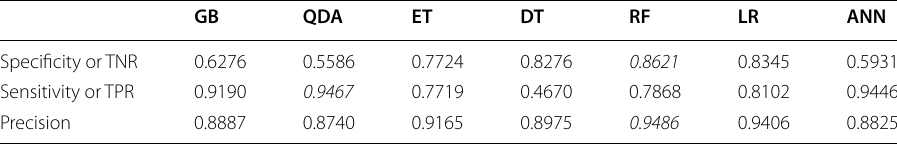
Italic characters show most successful scores of each row